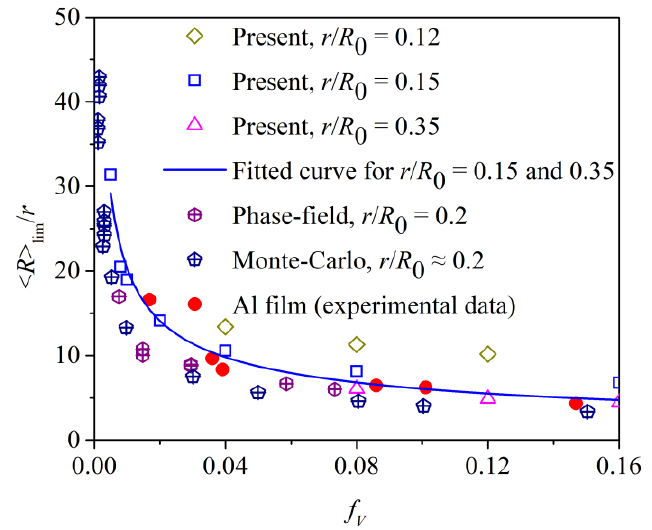
Figure 9. The results of the present CA model compared with the PF and MC simulation and experimental results.